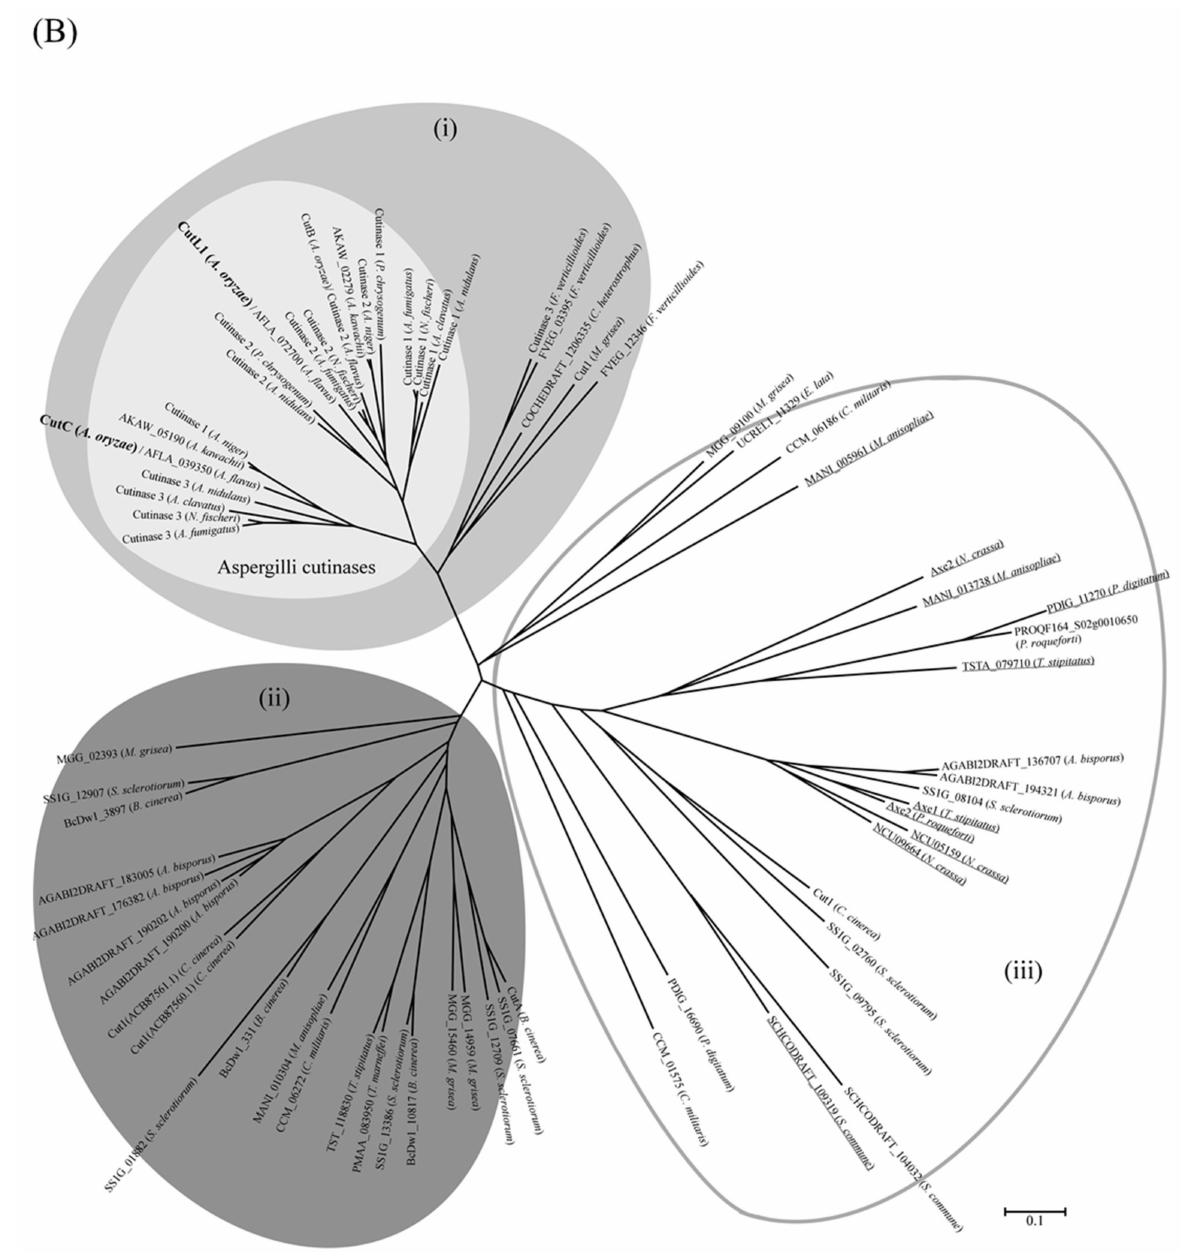
Figure 6. Phylogenetic analysis of ( A ) major class I hydrophobins and ( B ) cutinases and acetylxylan esterases. Acetylxylan esterases are underlined. The cutinases and acetylxylan esterases form the following three groups: ( i ) ascomycetes cutinases, including all Aspergilli cutinases; ( ii ) cutinases from other ascomycetes and basidiomycetes; and ( iii ) acetylxylan esterases and cutinases which show high similarities to acetylxylan esterases. All sequences are from ascomycetes or basidiomycetes (reproduced with permission from [8]. 2015, Molecular Microbiology